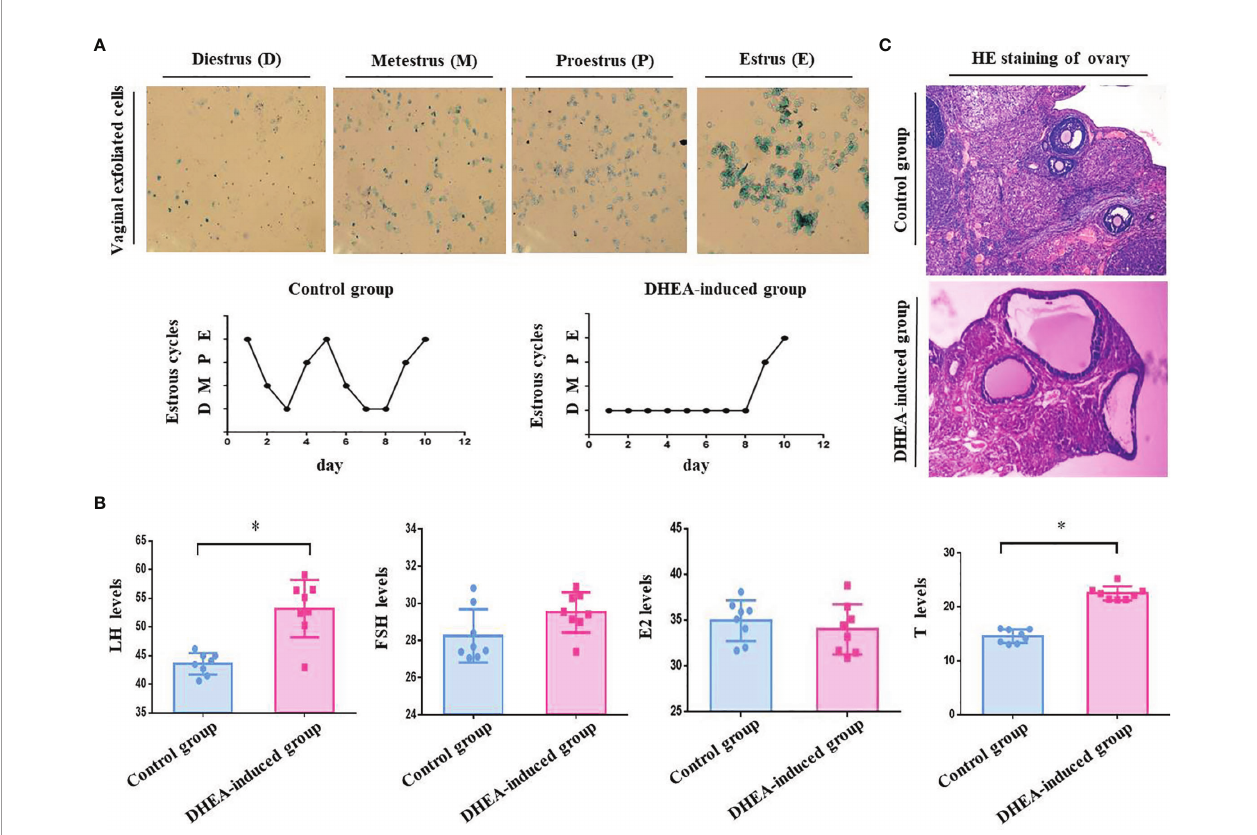
FIGURE 1 | (A) Vaginal exfoliated cells of rats were observed under a microscope. As shown in the pictures, large numbers of leukocytes and a small amount of mucus are observed in Diestrus (D). In Metestrus (M), several types of cells are observed, including nucleated epithelial cells, keratin epithelial cells and leukocytes. In Proestrus (P), most cells are nucleated epithelial cells. In Estrus (E), large numbers of keratin epithelial cells are observed. The estrous cycle of rats in the control group last 4- 5 days, whilst that of rats in PCOS model group (DHEA induced) was disordered or even remained in the estrous interphase. (B) Serum sex hormones in the orbital vein of rats detected by ELISA. The sex hormones including LH, FSH, T and E2 were detected after DHEA induction. According to the result of ELISA, the serum levels of LH (53.19 ± 7.6 mIU/mL) and T (22.53 ± 4.7 nmol/L) in the PCOS model group rats was signi fi cantly increased compared with those in the control group (LH, 43.55 ± 6.7 mIU/mL; T, 14.60 ± 4.4 nmol/L), there were no obviously difference in the serum level of E2 (PCOS, 34.01 ± 9.7 pmol/L vs Control, 34.96 ± 7.9 pmol/L) and FSH (PCOS, 29.52 ± 3.8 mIU/mL vs Control, 28.26 ± 5.1 mIU/mL) between two groups. (C) Pathological morphology of rat ovarian tissues stained with HE. As shown in photos, no structural abnormalities were present in the control group rats: the ovarian tissue was pink, the follicles and corpora lutea were in varying stages of development, and number of GC layers was 6 – 8. Differences in PCOS model group rats were signi fi cant: the color of ovarian tissue was generally lighter, the number of cystic follicles (large fl uid- fi lled cysts) was increased, and the GC layers were abnormal (only 2 – 4 or even less), and the number of corpora lutea sharply decreased. *P <